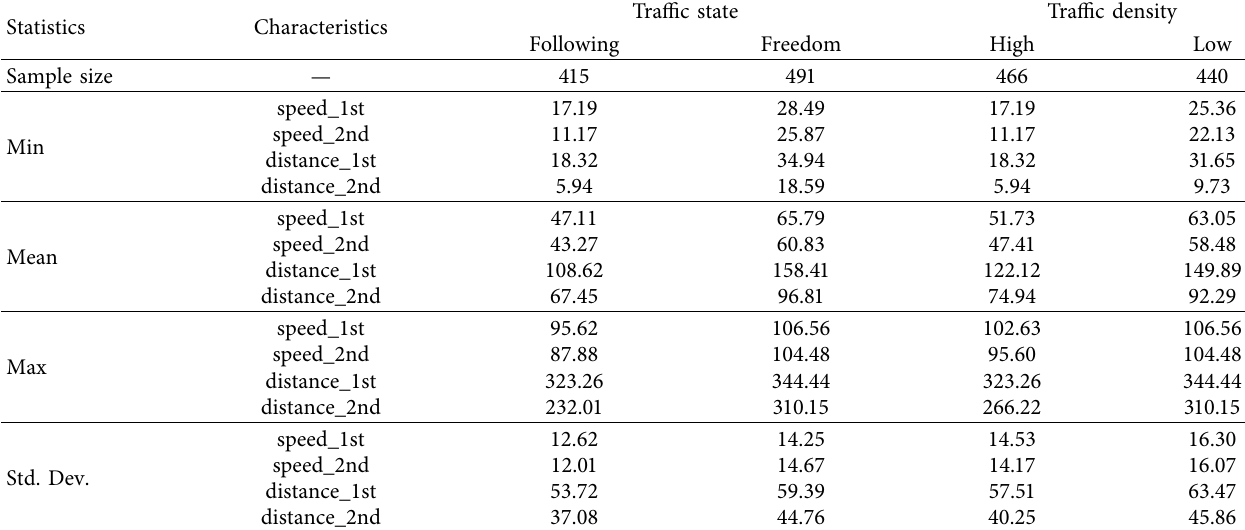
Table 4: Descriptive statistics of reaction characteristics.